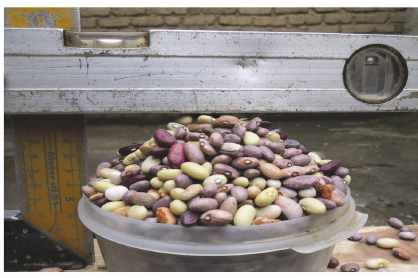
Figure 5: Beans in a vessel for angle of repose measurement.